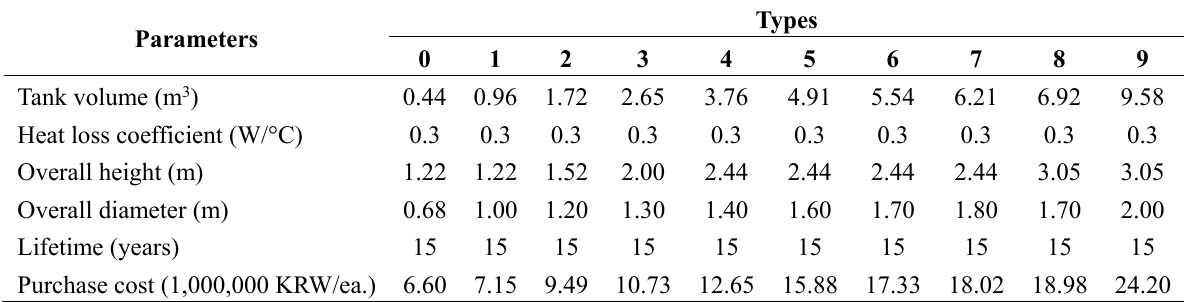
Table 2. Technical and economic parameters of the storage tanks for the case study.